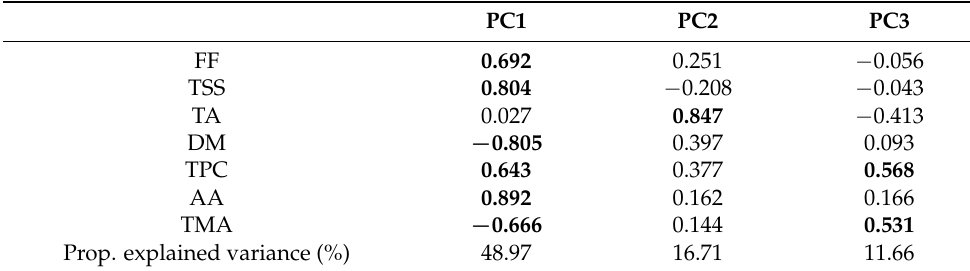
Table 3. Principal component analysis per harvest time. Numbers in bold refer to correlation coeffi- cient higher than 0.5 (assumed to be the conventional threshold) between the principal components (PC1, PC2, and PC3) and variables. The proportion of explained variance is